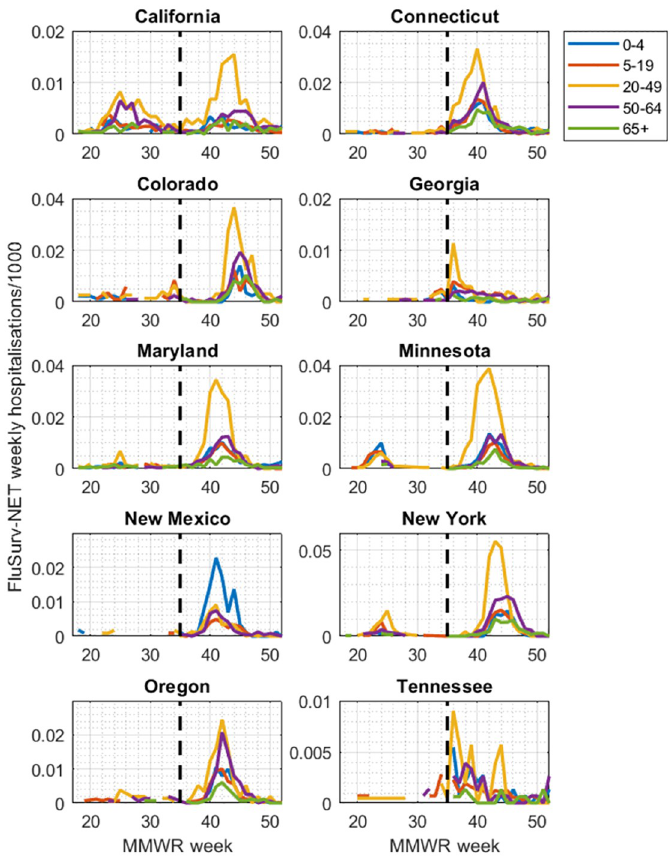
Fig 1. FluSurv-NET data from the 2009 H1N1 pandemic in the USA. Shown is weekly, age-specific data collected by the US Centers for Disease Control and Prevention (CDC), for hospitalisations that were laboratory confirmed as being pandemic H1N1. Each colour denotes a different age group, as indicated by the legend. Panels show data from the different states reporting FluSurv-NET data. Weeks are numbers along the x-axis according to MMWR numbering with, for example, week 35 corresponding to the week beginning on Sunday 30th August. Note that the y -axis varies between states. As described in the main text, several of these states (e.g. California) show clear signs of distinct spring and fall waves. For the purpose of the model, we used these data in combination with CDC estimates for the proportion of symptomatic cases that are hospitalised, laboratory tested, and reported through this dataset.